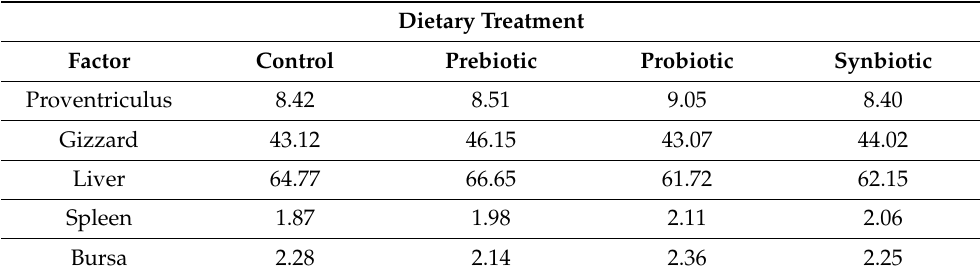
Table 2. Comparison of the effects of various feed additives on the development of internal organs in poultry [126]. Dietary Treatment Factor Control Prebiotic Probiotic